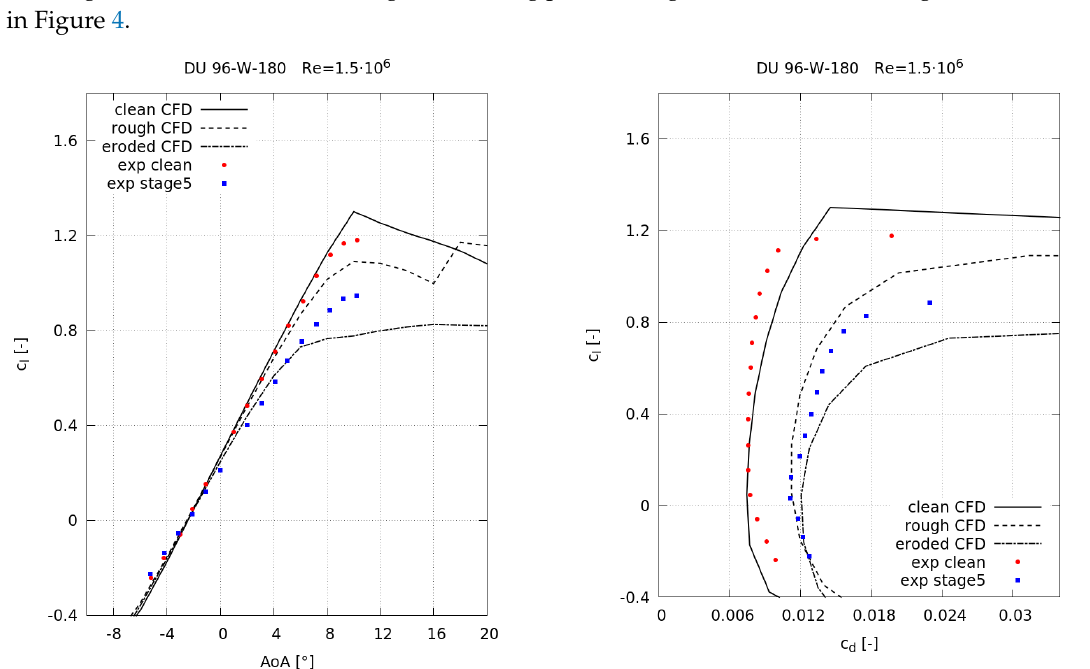
Figure 4. Validation of numerical results by Computational Fluid Dynamics (CFD) against wind tunnel measurements of a DU 96-W-180 at Re = 1.5 × 10 6 (“clean CFD” refers to resolved boundary layer with transition model, whereas “rough CFD” refers to the use of wall functions with fully-turbulent flow model and “eroded CFD” refers to a changed leading edge shape with resolved boundary layer and fully-turbulent flow